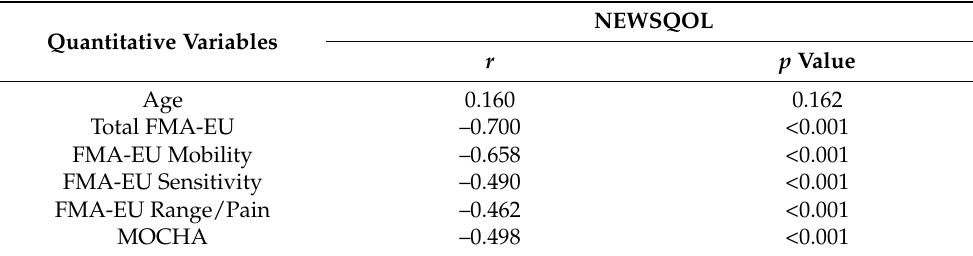
Table 7. Relationship between the different quantitative study variables and quality of